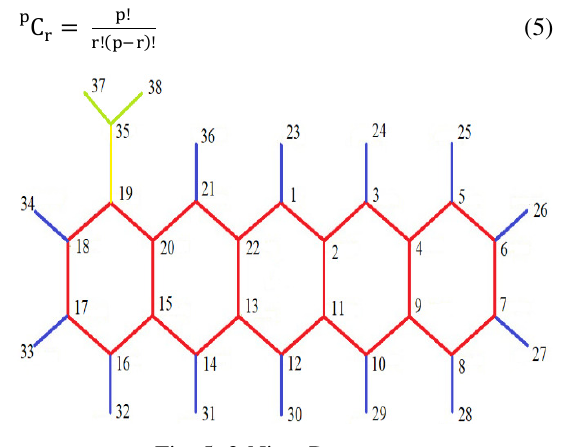
Fig. 5: 2-Nitro-Pentacene